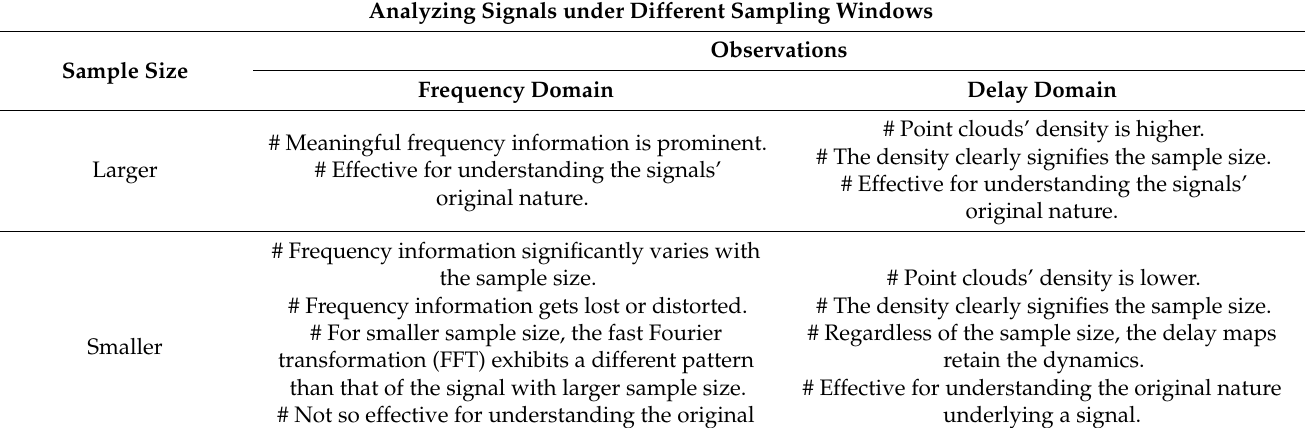
Table 3. Summary of observations from manufacturing signal processing. Analyzing Signals under Different Sampling